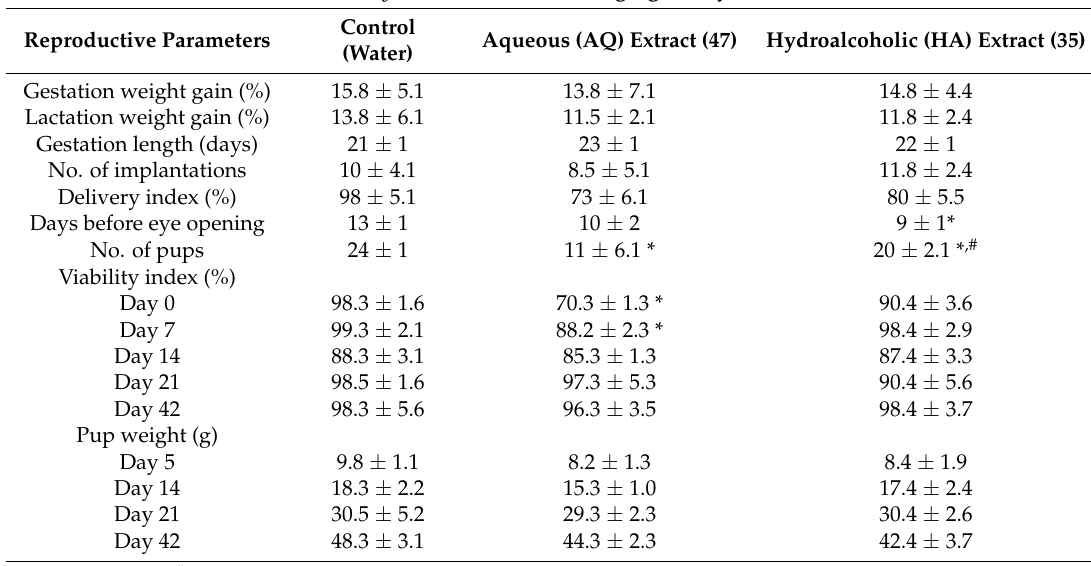
Table 2. Reproductive